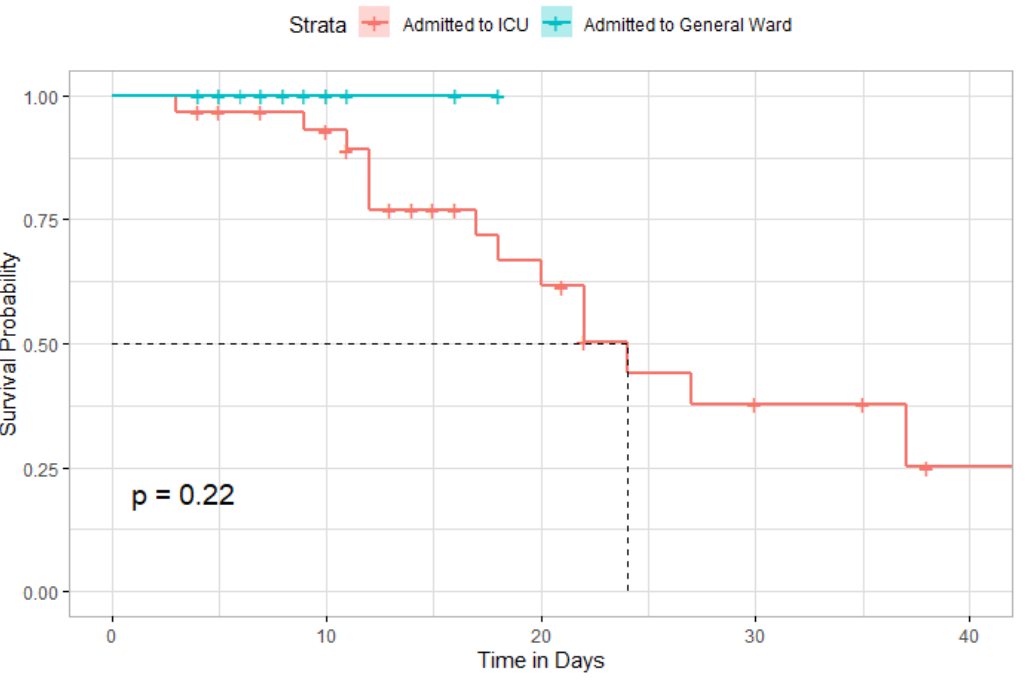
Figure 9. Kaplan – Meier curve comparing the survival distribution between admitted patients to Figure 9. Kaplan–Meier curve comparing the survival distribution between admitted patients to ICU ICU or general ward. or general